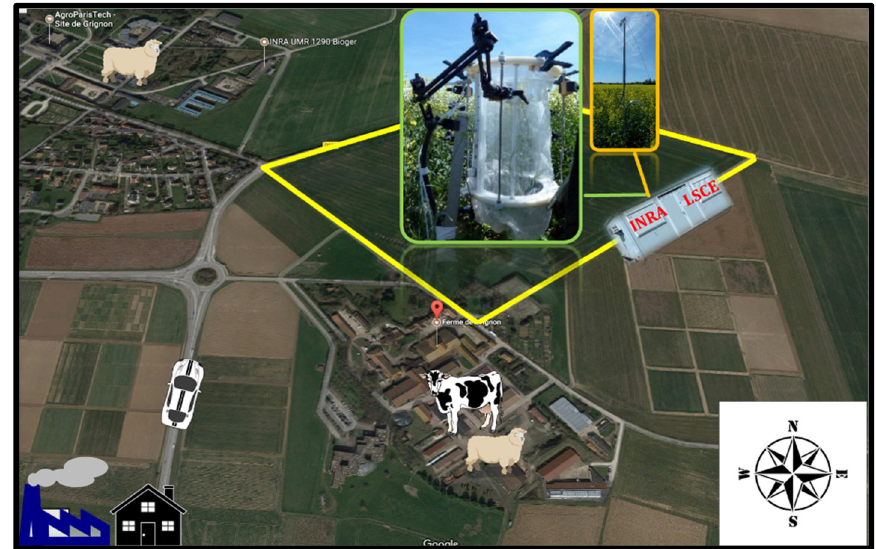
Figure 1. Satellite image of Grignon farm, the surrounding area and the chamber used for this study.